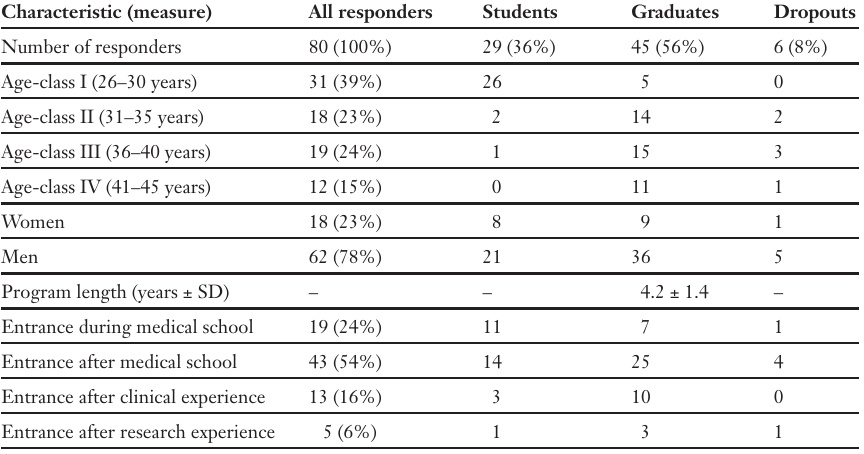
Demographic charac- teristics and back- ground of all (80) re-